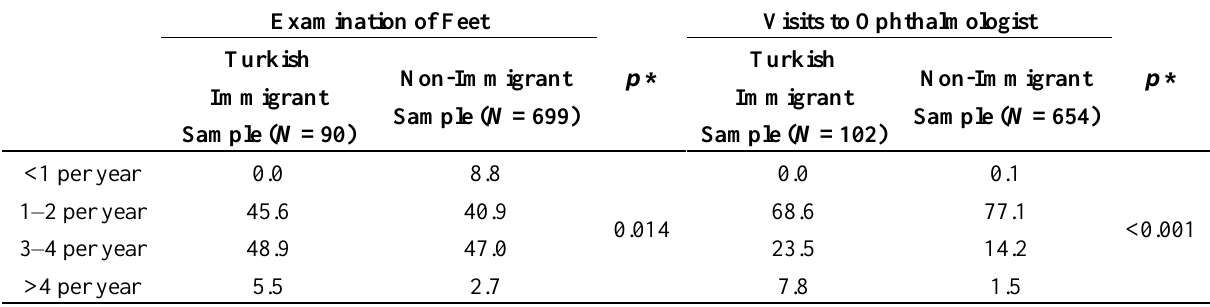
Table 2. Process quality: frequency of feet examination and visits to ophthalmologist (%). Examination of